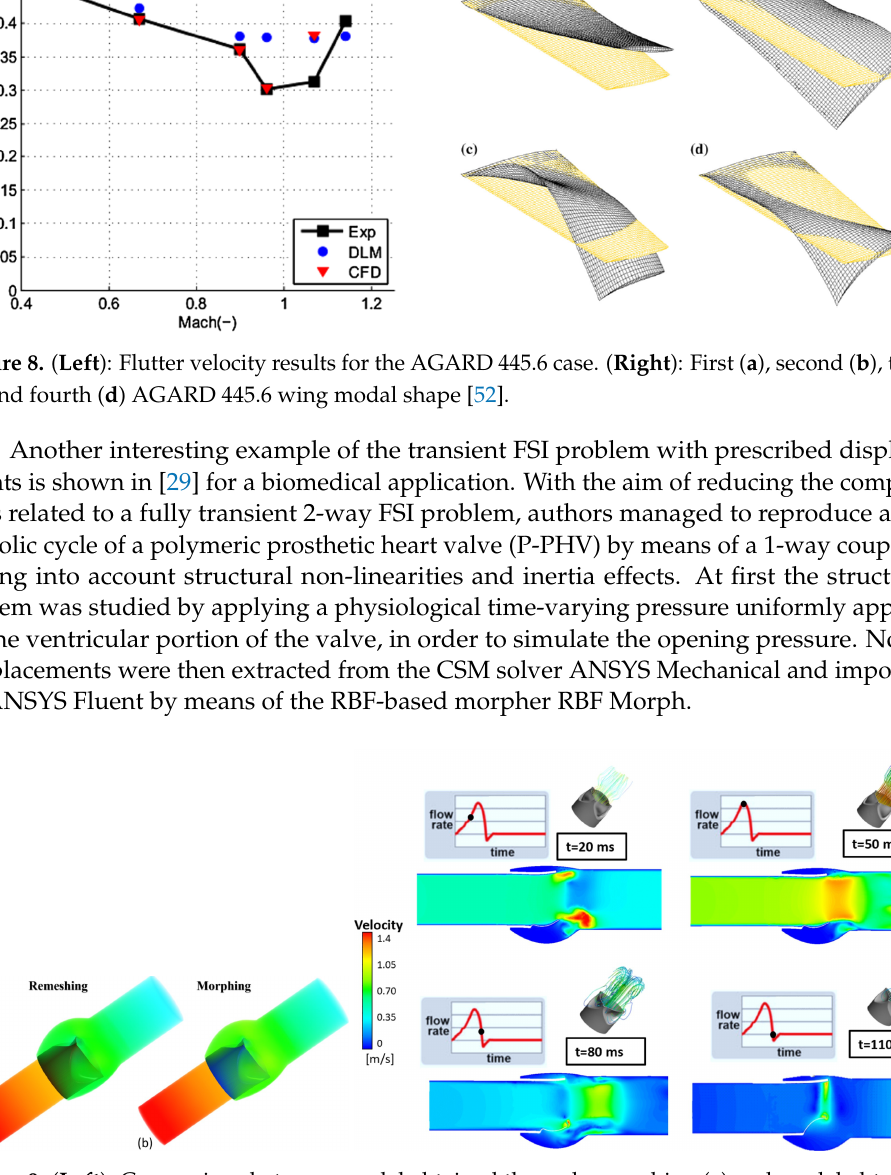
Figure 9. ( Left ): Comparison between model obtained through remeshing (a) and model obtained with mesh morphing (b). ( Right ): systolic cycle